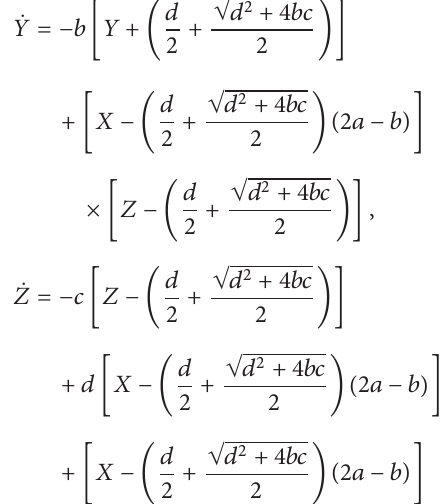
(c) The power spectrums of the dynamic system with 𝑎 = 0.9, 𝑏 = (d) The power spectrums of the dynamic system with 𝑎 = 0.9, 𝑏 = 12, 𝑐 = 6, 𝑑 = 0.06, and 𝑒 = 25 20, 𝑐 = 8, 𝑑 = 0.06, and 𝑒 = 25 Figure 9: The power spectrums of the dynamic system when 𝑥 = 11.28 , 𝑦 = −11.21 , 𝑧 = −9 , and 𝑤 = 20.49 . (The red color stands for the power spectrum of 𝑥 ; the yellow color stands for the power spectrum of 𝑦 ; the blue color stands for the power spectrum of 𝑧 ; and the green color stands for the power spectrum of 𝑤